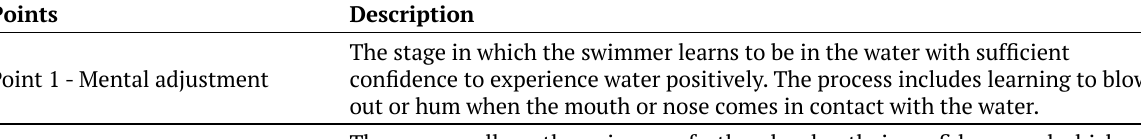
Table 1. Detailed description of the Halliwick concept points of progression [13,